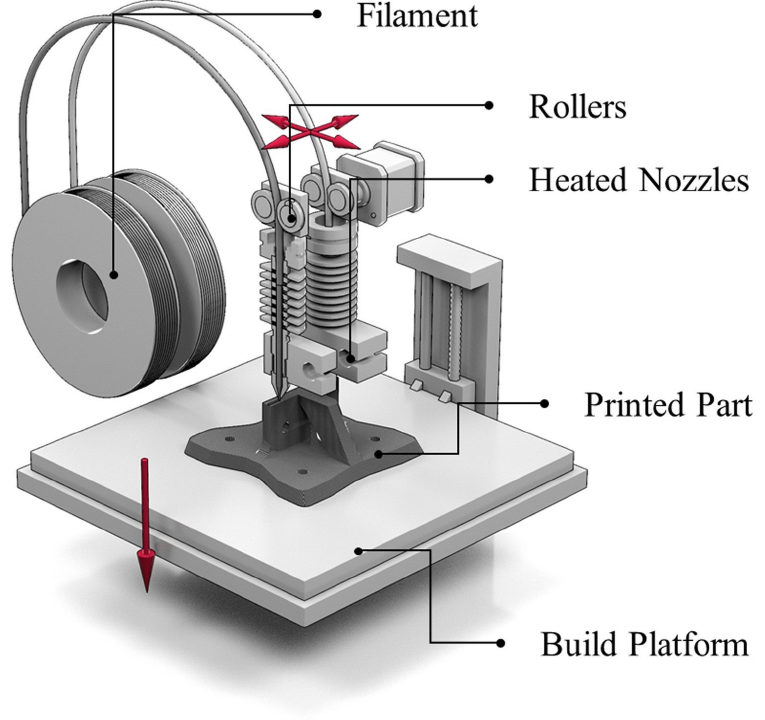
Figure 7. Schematic of 3D printing with FFF (reproduced with permission from Reference [21], Copyright 2020 Elsevier).